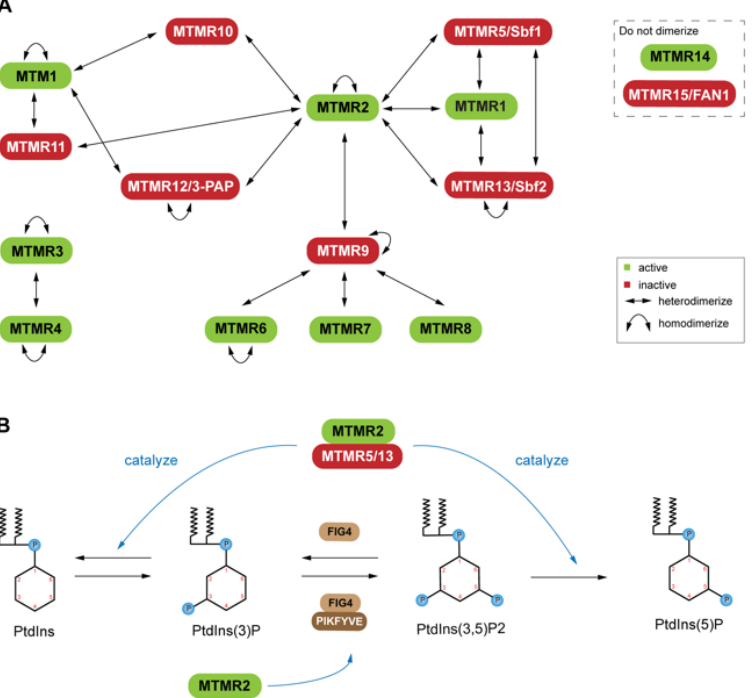
Figure 1. Dimerization states of the myotubularin (MTM) family: ( A ) Active and catalytically inactive forms are indicated in green and red, respectively. Active and inactive coupling (heterodimerization) is common; however, self-association (homodimerization) has also been reported among both active and inactive MTMs. MTMR14 and MTMR15 are not known to dimerize. ( B ) Phosphorylation schema for phosphatidylinositol (PtdIns), a molecule important for endosomal-lysosomal membrane trafficking, with example PtdIns kinases (PIKFYVE) and non-MTM phosphatases (FIG4), along with active and inactive MTMs (labelled green and red, respectively). Heterodimerization of an active (MTMR2) and inactive (MTMR5, MTMR13) leads to a stabilized complex with PtdIns phosphatase potential. MTMR2 and FIG4 interactions have been implicated in vivo, though further characterization is necessary.